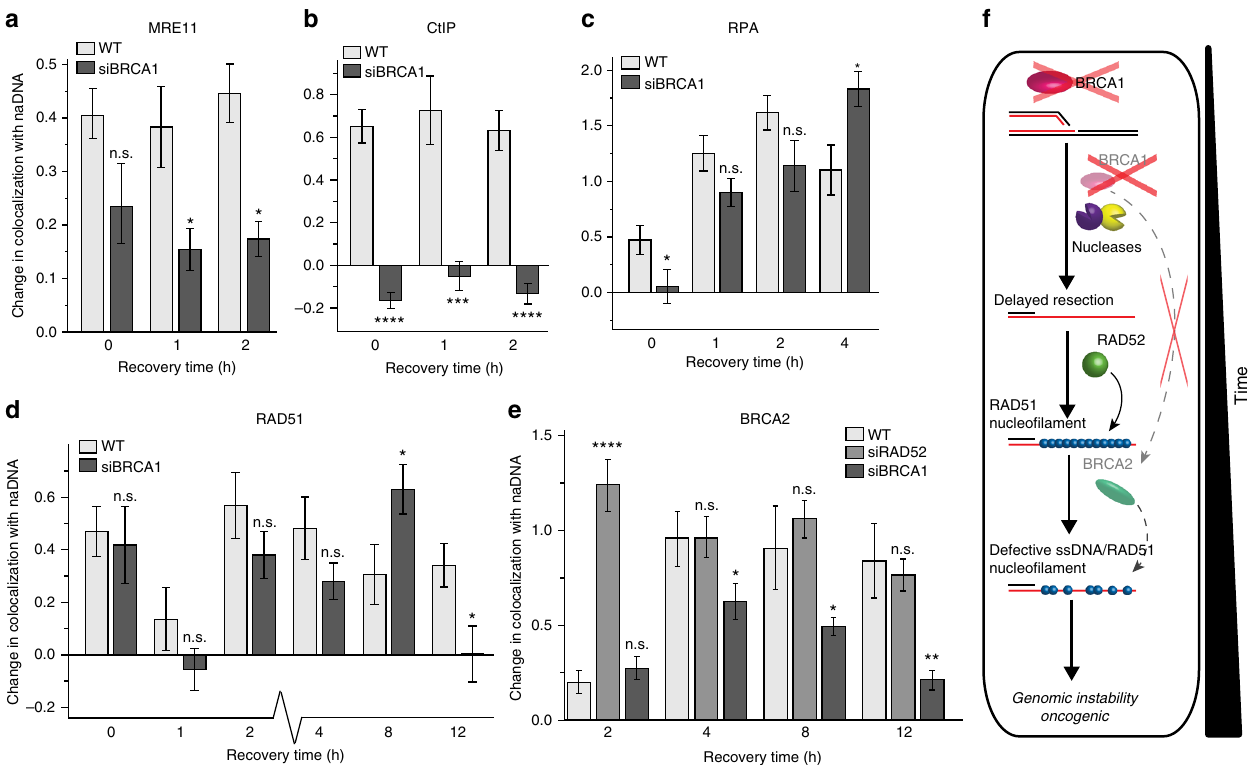
Fig. 6 BRCA1 is necessary for BRCA2 mediation of ssDNA/RAD51 interactions. a Quanti fi cation of MRE11 association with repair foci during early HR (0, 1, 2 h) in BRCA1-depleted cells. b Quanti fi cation of CtIP association with repair foci during early HR (0, 1, 2 h) in BRCA1-depleted cells. c Quanti fi cation of RPA association with repair foci during early HR (0, 1, 2, 4 h) in BRCA1-depleted cells. d Quanti fi cation of RAD51 association with repair foci throughout HR (0, 1, 2, 4, 8, 12 h) in BRCA1-depleted cells. e Quanti fi cation of BRCA2 association with repair foci during HR (2, 4, 8, 12 h) in BRCA1- and RAD52- depleted cells. f A representation of the HR repair pathway de fi ciency in BRCA1 depleted cells. For complete N values, see Supplementary Table 1. Error bars represent mean ± s.e.m. Student ’ s t test for signi fi cance between WT + CPT and either siBRCA1 + CPT or siRAD52 + CPT as indicated. n.s. p > 0.05, * p < 0.05, ** p < 0.01, *** p < 0.001, **** p <